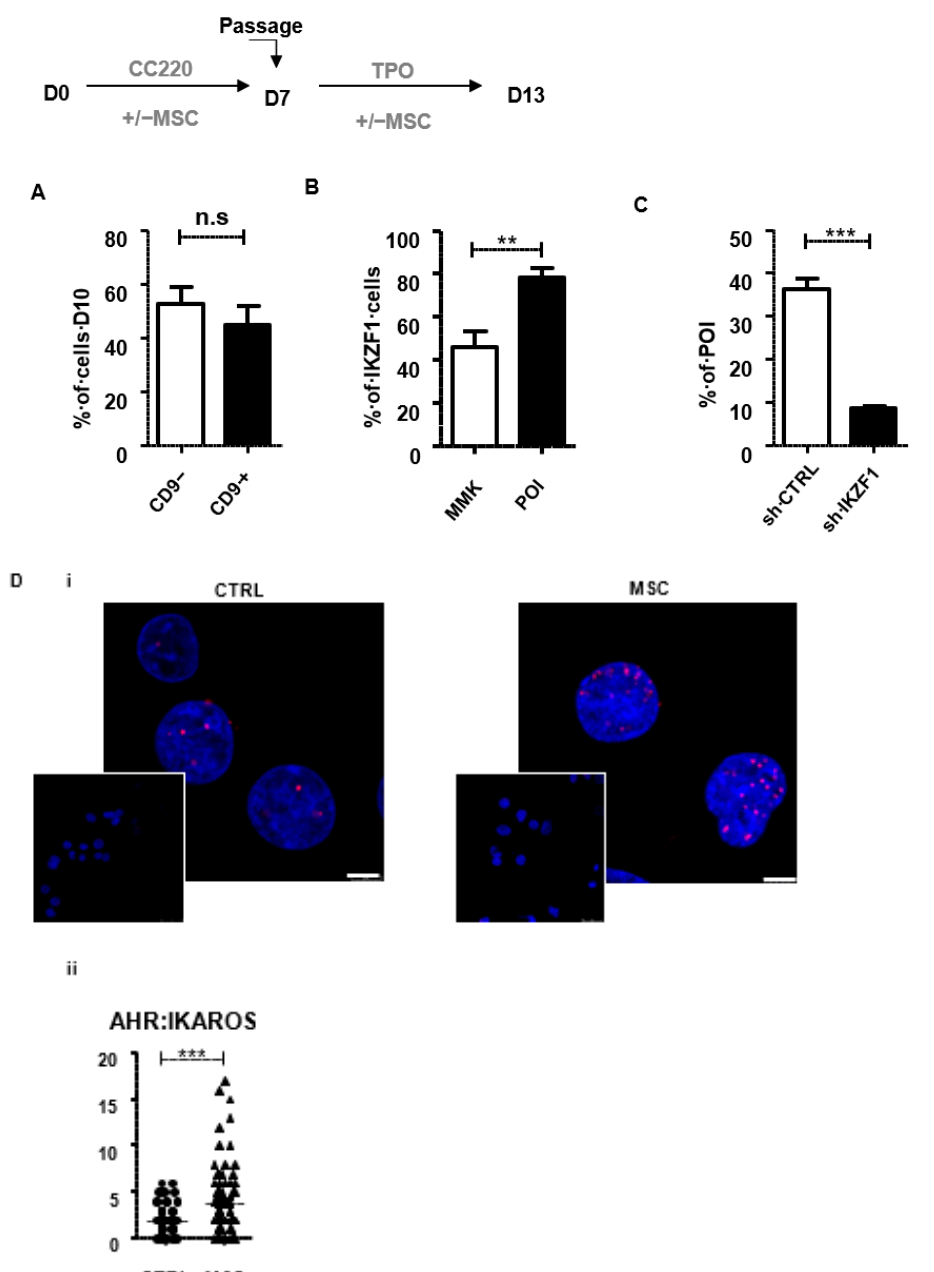
Figure 3. The AHR:IKAROS interaction is involved in MSC-triggered POI amplification. Peripheral blood CD34 + cells were cultured in the absence or presence of monolayer of MSC in serum free medium containing a CC220 cytokine cocktail from day 0 to 7 and with TPO from day 7 to 10. ( A ) Bar graphs representing the percentage of CD9 + and CD9 − subpopulations within the CD34 + CD41 low population obtained at day 10 and analysed by flow cytometry (52.8 ± 6.1% of CD34 + CD41 + CD9 − cells vs. 44.7 ± 7.0% of CD34 + CD41 + CD9 + cells) (mean ± SEM, n = 3, ns p > 0.05, Student t test) ( B ) Bar graphs representing the percentage of IKZF1 expression in MSC-derived POI or MSC-derived MMK (78.2 ± 4.6 in POI vs. 45.9 ± 7 in MMK) (mean ± SEM, n = 3, ** p < 0.01, Student t test). ( C ) Bar graphs representing the percentage of MSC-derived POI obtained following CD34 + cells transduction with shIKZF1 or sh scramble (8.4 ± 0.6 of shIKZF1-derived POI vs. 36.2 ± 2.5 sh scramble -derived POI) (mean ± SEM, n = 3, *** p < 0.001, Student t test) ( D ) (i) Representative images of interaction between AHR and IKAROS analyzed by PLA in MSC-derived POI and in control POI without MSC, scale bar: 5 µ m. (ii) Dot plots representing the number of positive signals/nucleus in POI obtained in response to CTRL or in MSC conditions. Positive signals were counted on 10 images 50 cells (1.9 ± 0.2 signals in the control vs. 3.7 ± 0.4 signals per POI with MSC, *** p <